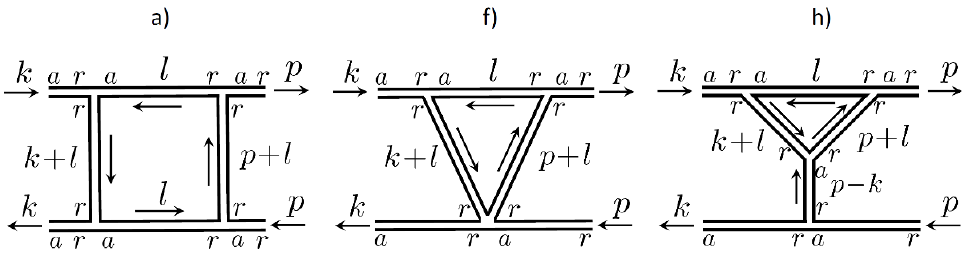
Figure 8 . Rungs a), f) and h) from (cid:12)gure 7 shown with momentum convention and one out of many r and a